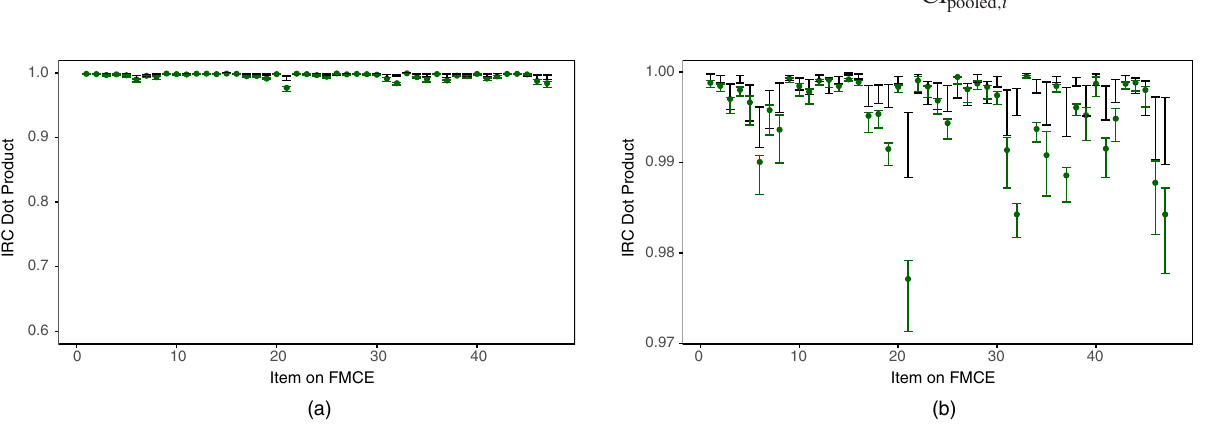
FIG. 6. The IRC dot product for each item on the FMCE is shown in green for our American dataset (RSW) and the IDW American dataset (IDWA). The green error bars around the data points represent the IRC dot product confidence intervals described in Sec. III C. The black error bars represent the randomized trial confidence intervals described in Sec. III B 3. The vertical range of (a) matches Figs. 5 and 7. Plot (b) contains the same information as (a), but a smaller vertical range is chosen to allow better